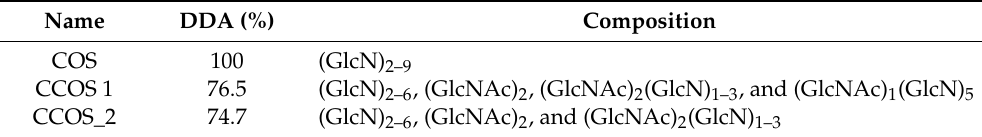
Figure 6. MALDI-TOF mass spectrometry profile of the chitosan oligosaccharide (COS) prepared from the chitosan hydrolysis process catalyzed by Paenibacillus sp. TKU047 chitosanase. Table 3. The characteristics of COS, CCOS_1, and CCOS_2.